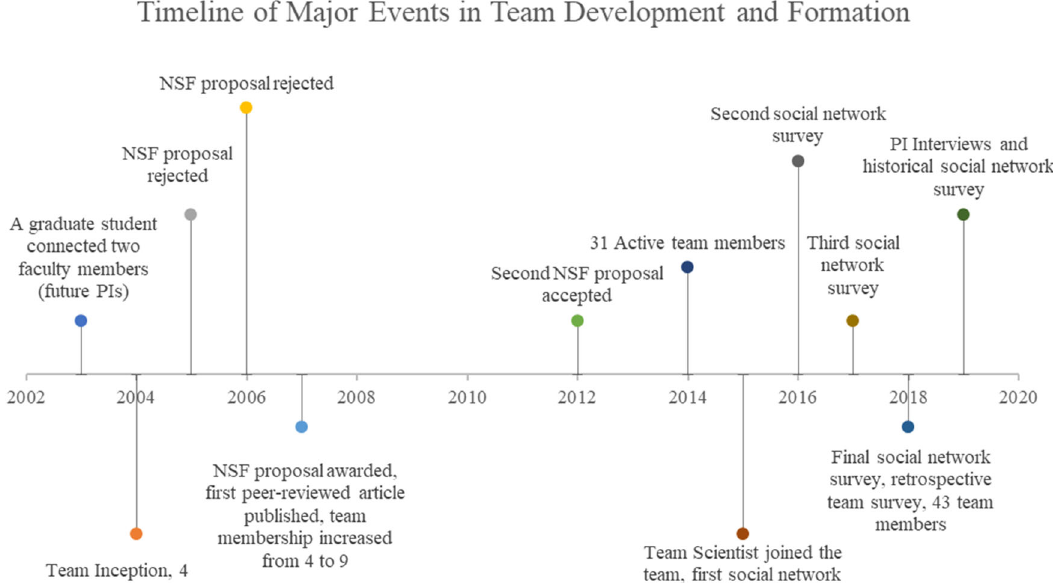
Fig. 1 Timeline of major events in team development and formation. Signi fi cant events occurring over 15 years during the development and formation of an exemplary